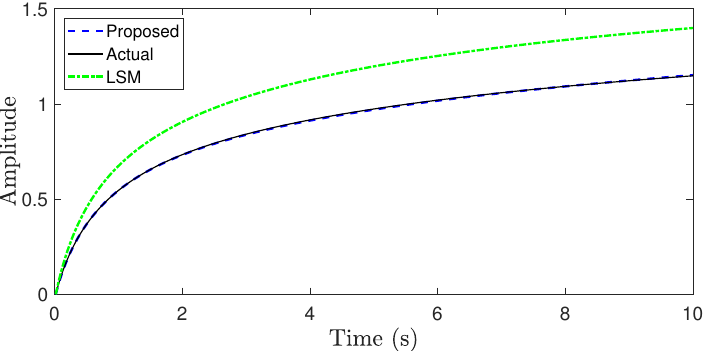
Figure 8. Step-response comparison of the linear subsystem for Example 2.